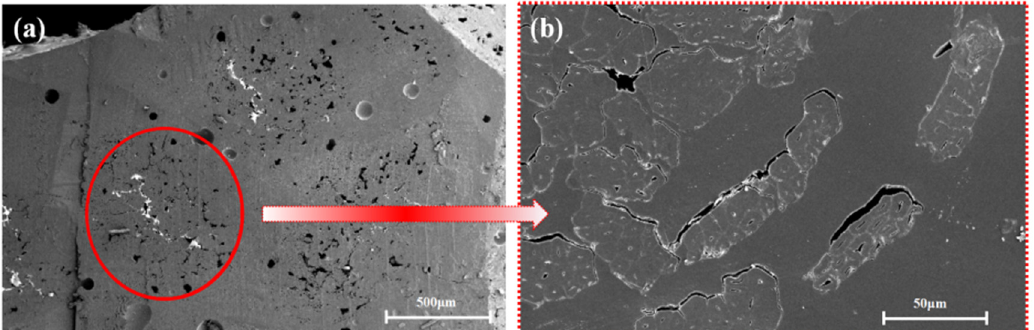
Figure 5. Microscopic morphology of cross-section of JF-NOL: ( a ), 50×; ( b ), 500×.